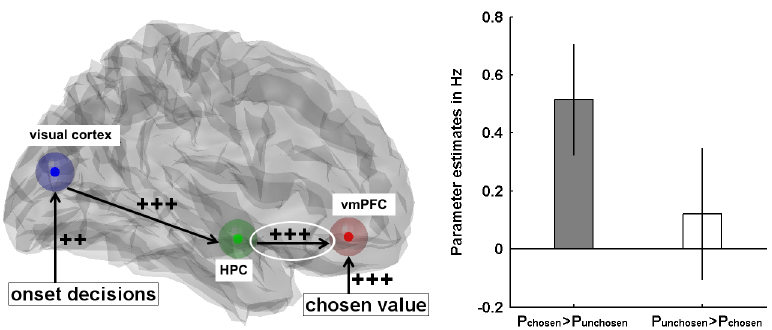
Figure 5. Effective connectivity in preferential choices from memory. Left : the most likely Dynamic Causal Model with connection strengths (“++” = positive at p < 0.01; “+++” = positive at p < 0.001); right : the connection from hippocampus to ventromedial prefrontal cortex (circled) was only significantly positive when participants chose the better remembered snack. Error bars represent 95% confidence intervals (adapted with permission from